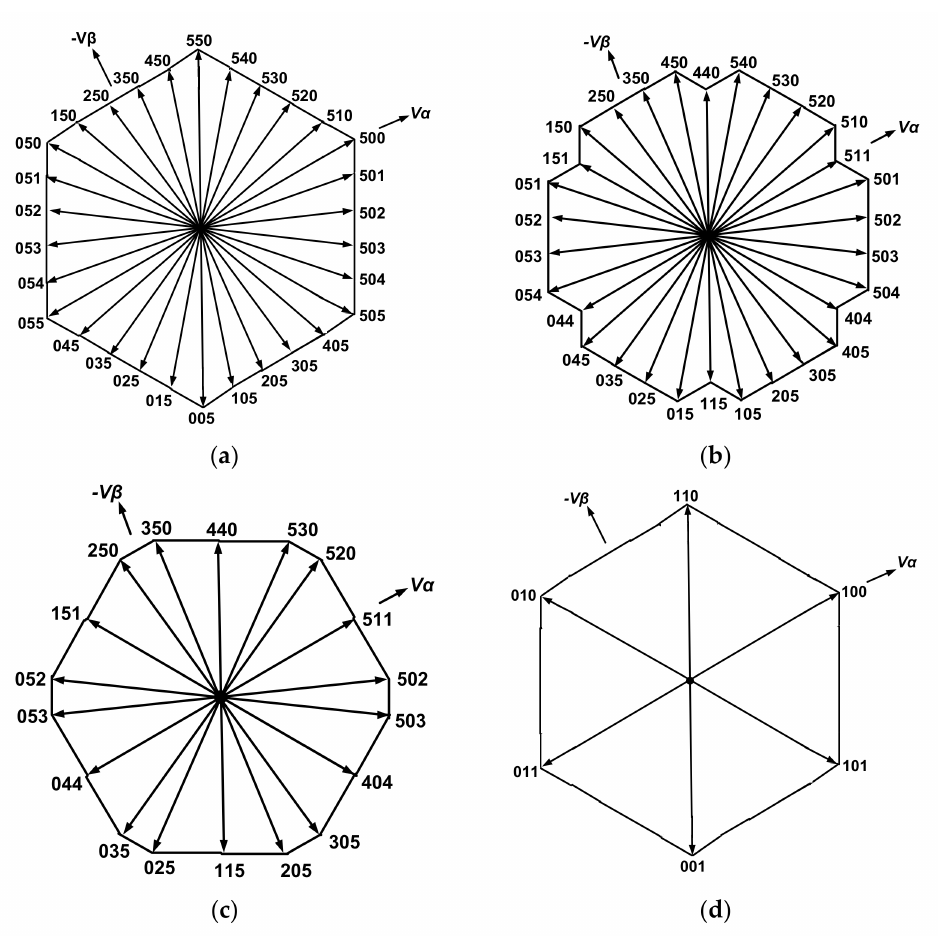
Figure 4. Space vector diagrams for the proposed MLI at: ( a ) Ma = 1.3, ( b ) Ma = 1.15, ( c ) Ma = 0.98 and ( d ) Ma =